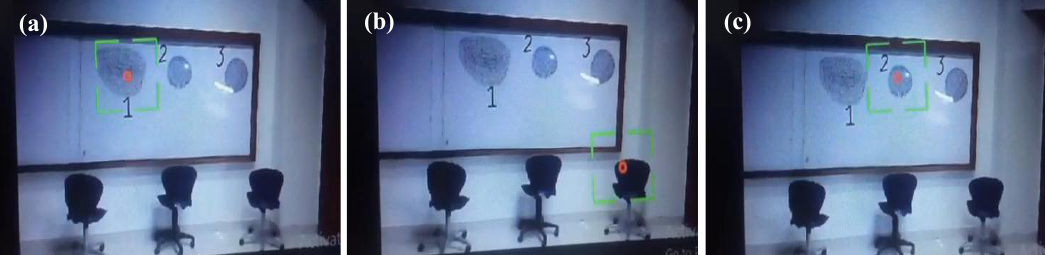
Figure 7. Results of eye ball